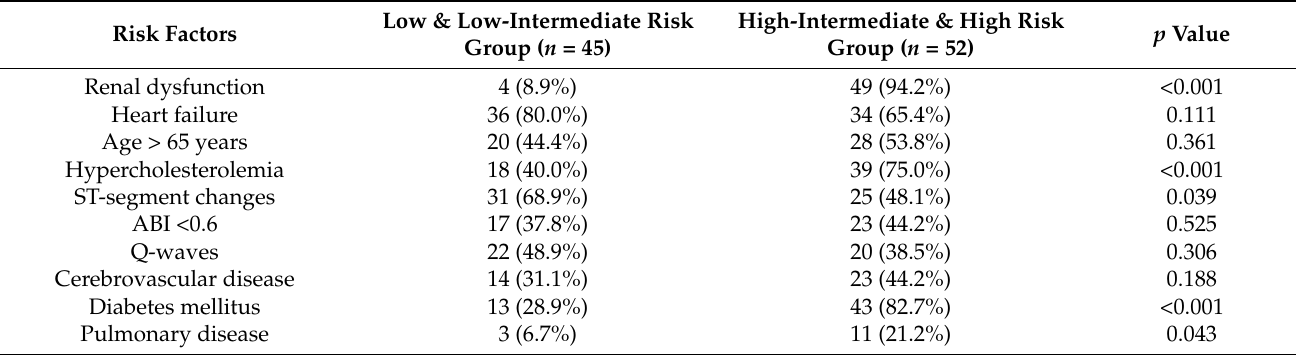
Table 2. Risk factors included in the prognostic index.